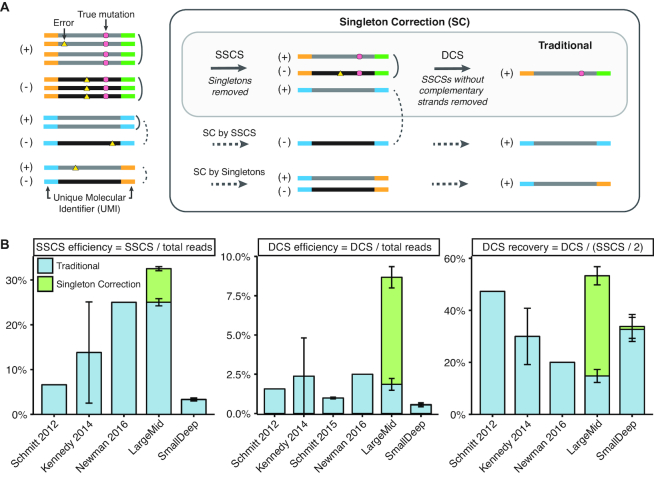
Singleton Correction improves traditional duplex UMI methods. (A) Singleton correction (SC) can be achieved through two strategies. (i) In the absence of redundant reads, singletons derived from complementary strands can be used to correct one another for SC by Singletons. (ii) If PCR duplicate reads are present only for one strand, they are first collapsed to form a single strand consensus sequence (SSCS). This can be subsequently used to correct the singleton of the complementary strand for SC by SSCS. Uncollapsed reads are not an accurate representation of molecular diversity and contain polymerase, sequencer, and oxidation errors. Traditional UMI methods of error suppression are restricted to molecules with redundant reads. Singleton Correction expands error suppression to duplex-matched singletons and enables error correction for a greater number of reads. (B) Comparisons of traditional duplex UMI methods from the indicated publications (8–10) and from this study (LargeMid, n = 12 libraries; SmallDeep, n = 8 libraries). Plot shows SSCS and duplex consensus sequence (DCS) efficiency and recovery for methods with traditional duplex UMI processing or with Singleton Correction. Efficiency is an assessment of over-sequencing relative to unique molecules, whereas recovery is an estimate of molecular retention after sequencing. Data are presented as mean ± S.D.